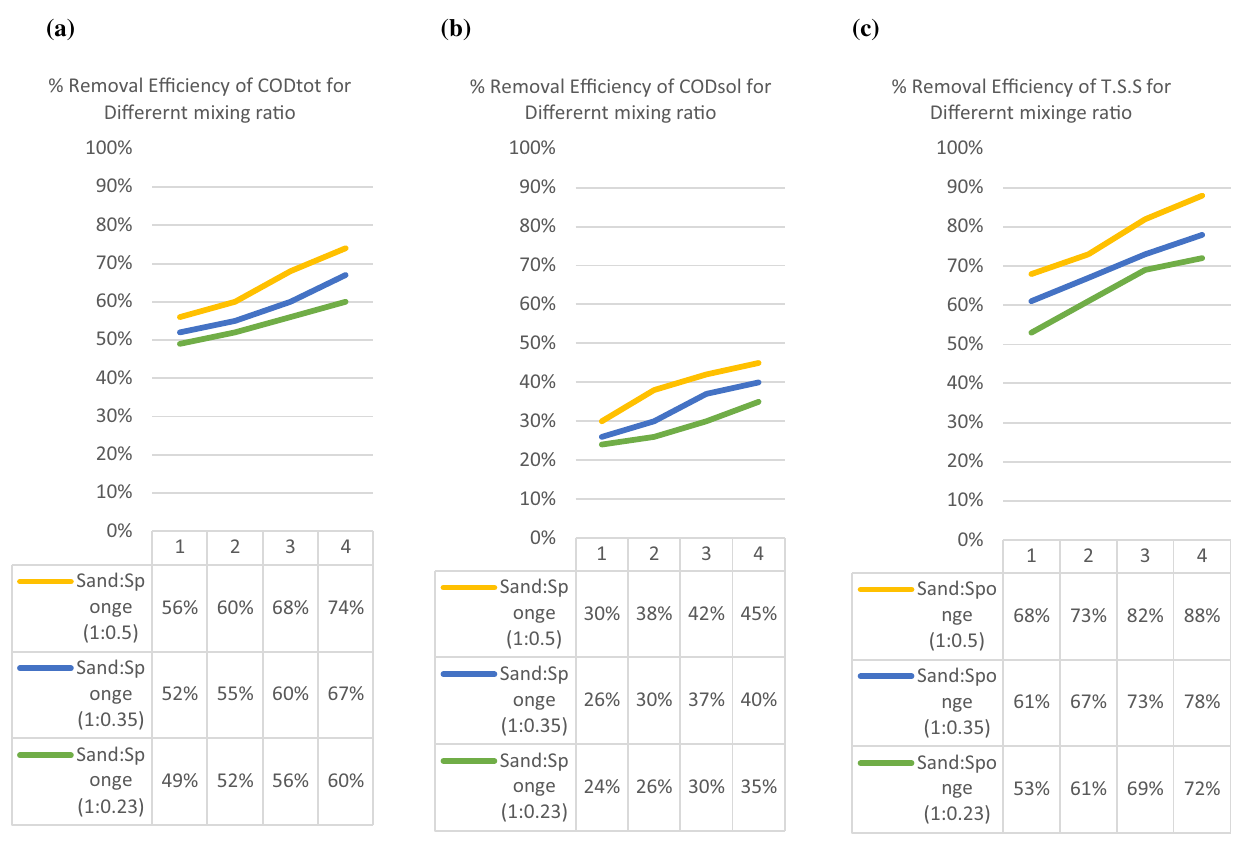
Fig. 11 Results obtained from run (2), a %R.E. of COD tot for different mixing ratios, b %R.E. of COD sol for different mixing ratios, c %R.E. of TSS for different mixing ratios